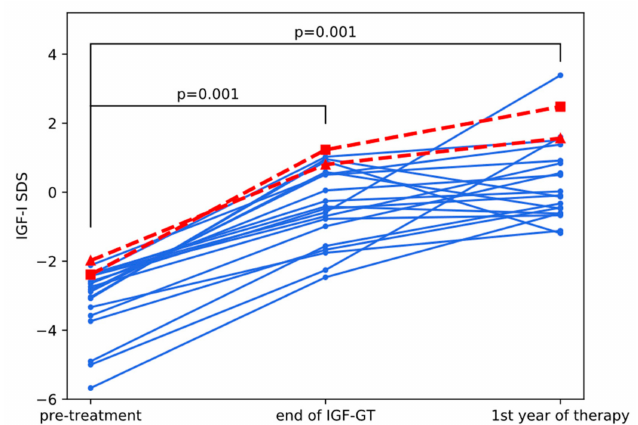
Figure 2. Changes in IGF-I SDS during IGF-I GT and first year of rhGH treatment in AGA-IGFD children. Red lines with triangle and square markers indicate nonresponders 1 and 2, respectively (Table 3). All significant p -values from Nemenyi post hoc test are shown.